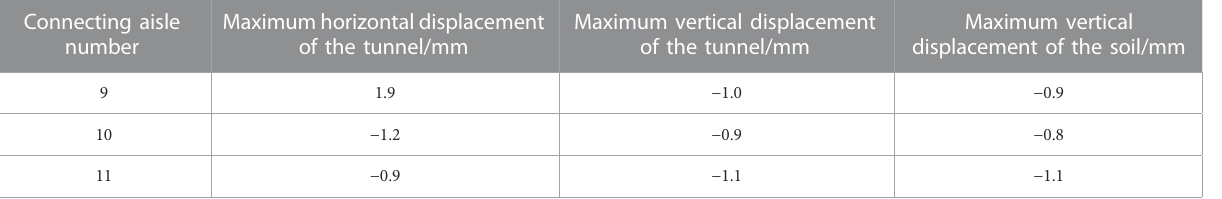
TABLE 4 Summary of the 3D fi nite element calculation